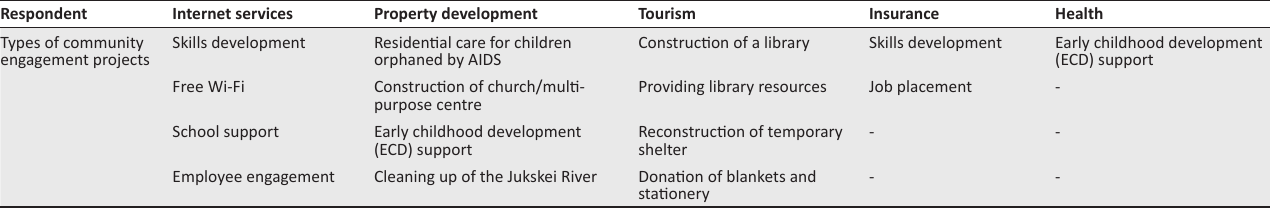
TABLE 1: Community engagement projects in